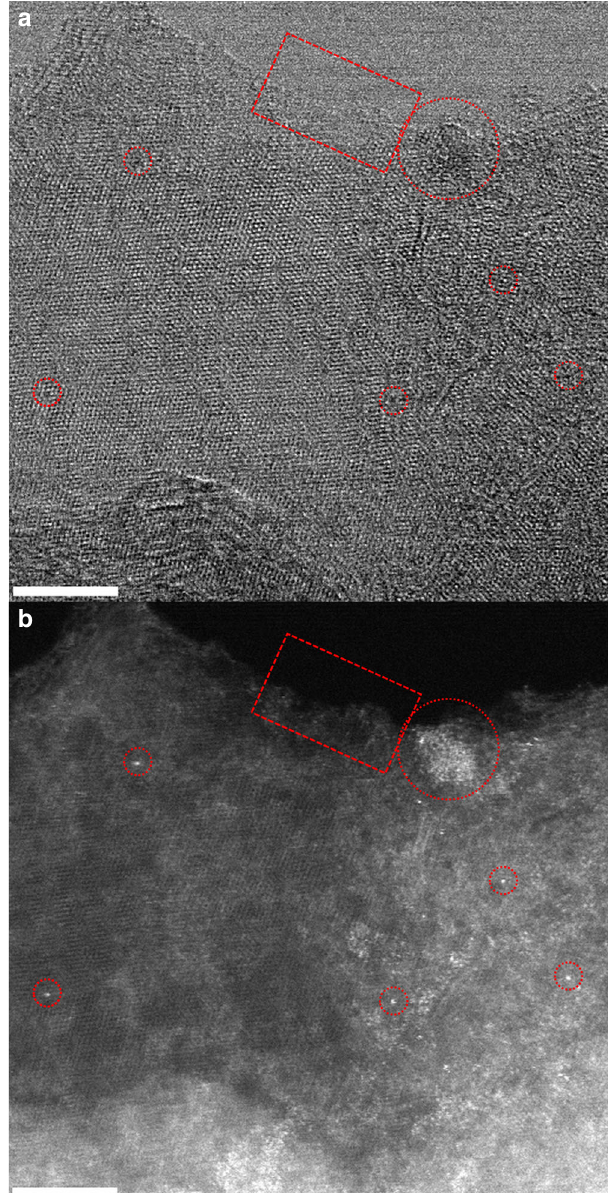
Fig. 3 Nanostructure of Fe/N-C sample. a Representative Bright Field and b HAADF STEM micrographs of sample Fe/N-C (scale bar 5 nm). The brightest spots in the HAADF STEM image are Fe atoms. Several morphologies are identi fi ed: Nanoparticles (circle); polyatomic species (rectangle) and single atoms (small